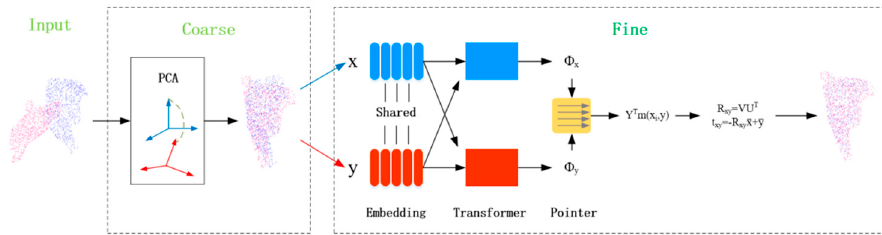
Figure 5. Coarse ‐ to ‐ fine registration structure. Figure 5. Coarse-to-fine registration structure.